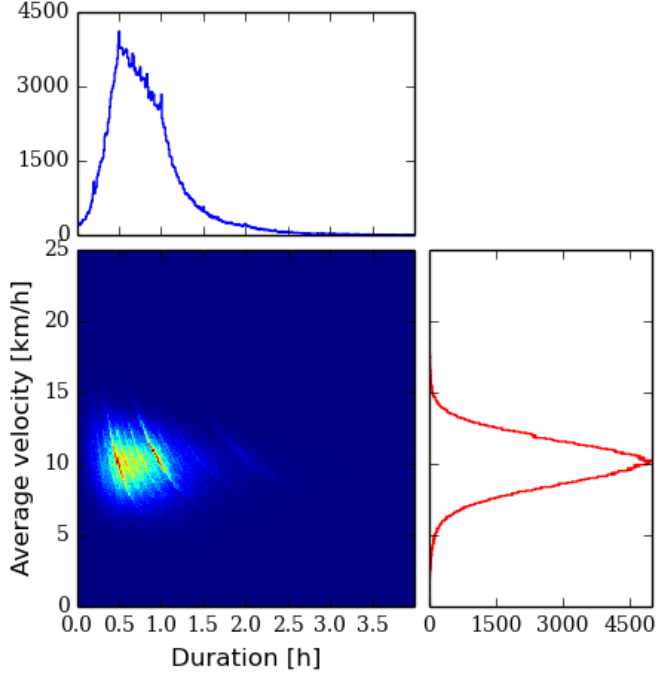
Figure 1. Histogram of the running tracks in terms of duration and average velocity with marginal